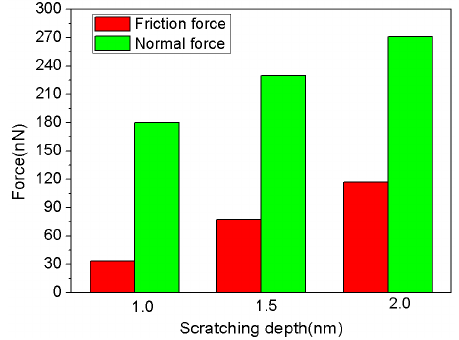
Figure 8. The average normal force and friction force for different scratching depths.